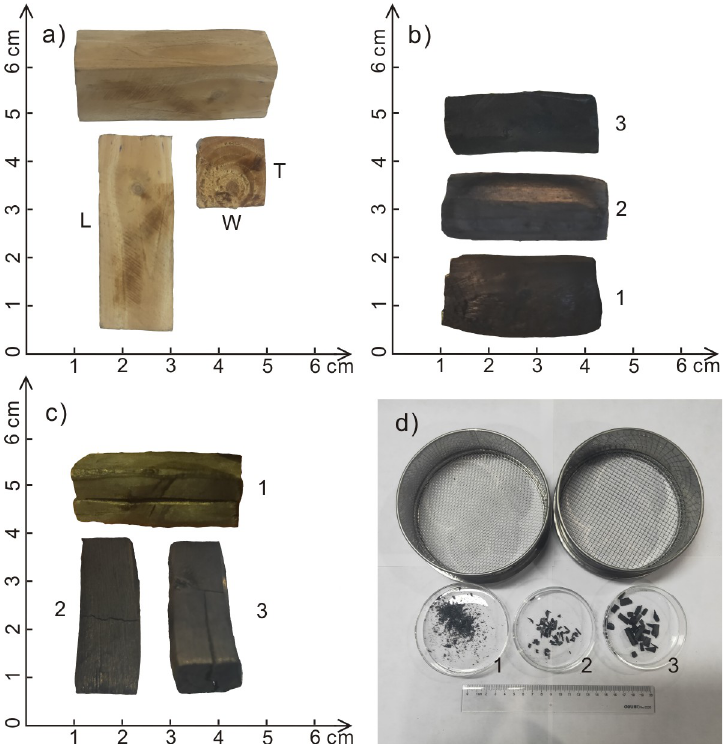
Fig 2. (a) Wood sample (L: length, W: width, T: thickness); (b) charcoal volume at 400˚C (1. Cunninghamia , 2. Cinnamomum , 3. Magnolia ); (c) part of the charcoal fissures at 500˚C (1. Cotinus , 2. Betula , 3. Quercus ); (d) charcoal fragments after compression test (1. < 2mm, 2.2-4mm, 3. >